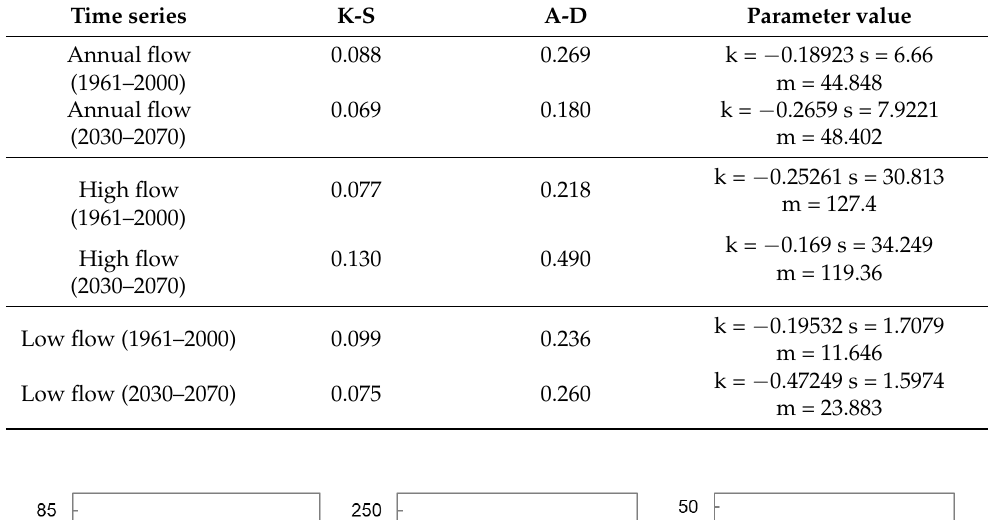
Table 5. Fitting results from GEV distribution.